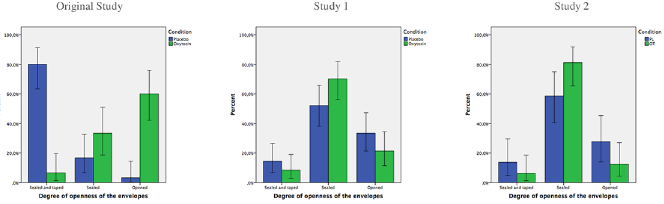
Fig 1. Percentage of participants displaying each behavior in the placebo and oxytocin condition for each